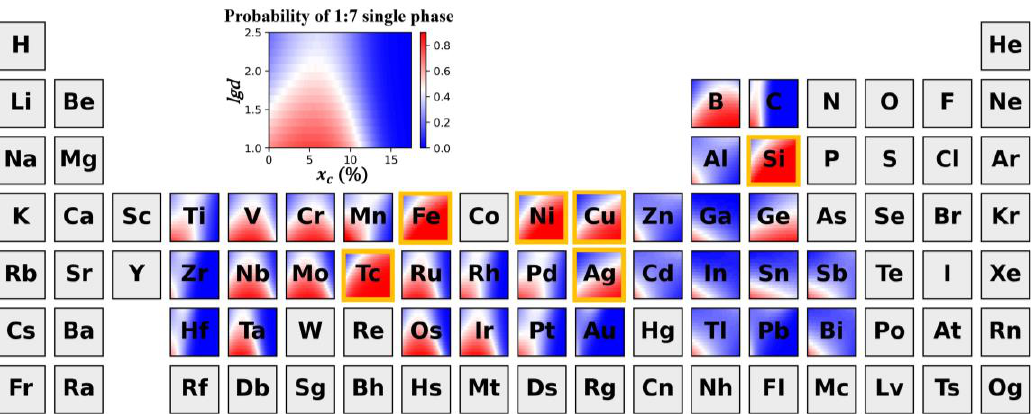
Figure 6. High-throughput prediction for the phase constitution of prepared SmCo 7 − x M x bulk al-